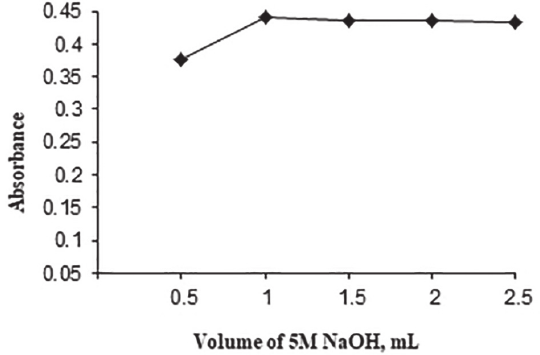
FIGURE 5 - Effect of NaOH in method (B) (VLGH: 20 µg mL -1 ).